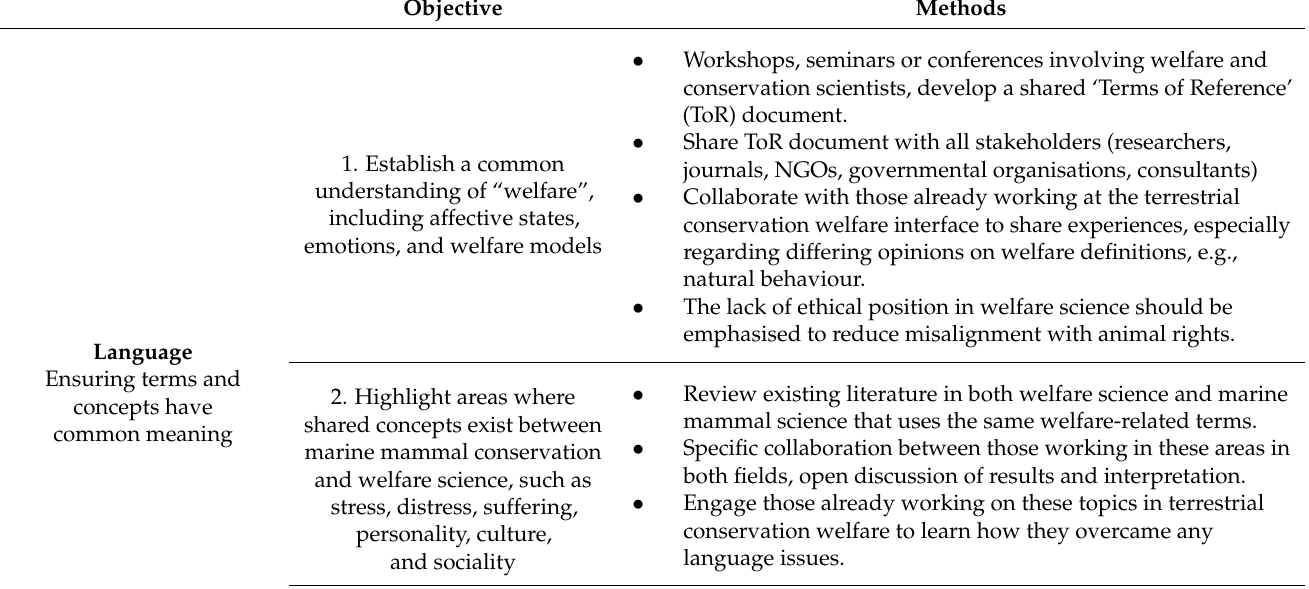
Table 1. Suggested objectives and methods for addressing the language, translation and reception issues relating to applying welfare science principles to marine mammal